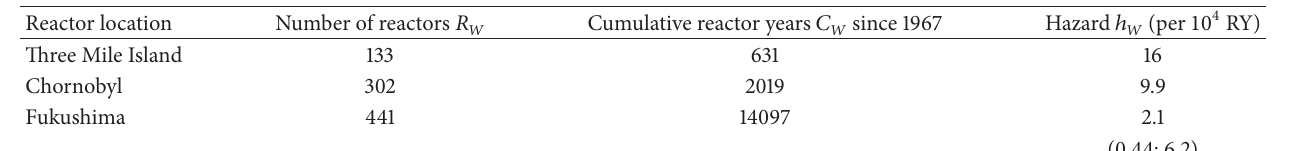
Table 2: Worldwide number 𝑅 𝑊 of reactors at the time of accident, cumulative reactor years since 1967, and hazard of NPP reactor accidents with INES level ≥ 5 (95% CI in brackets are only calculated for the latest value based on three events).